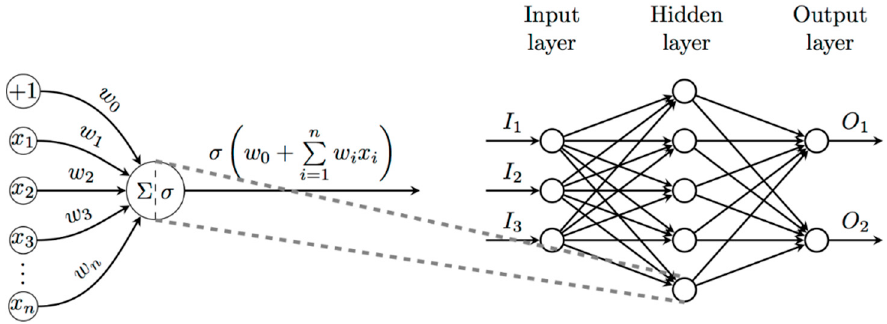
Figure 1 . Structure of an artificial neural network. Figure 1. Structure of an artificial neural